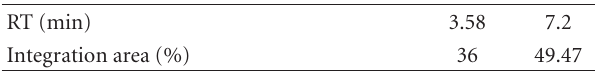
Table 2: RT and integration area of HPLC peaks about products after 60 mins of photoreaction in presence of Fe 3 O 4